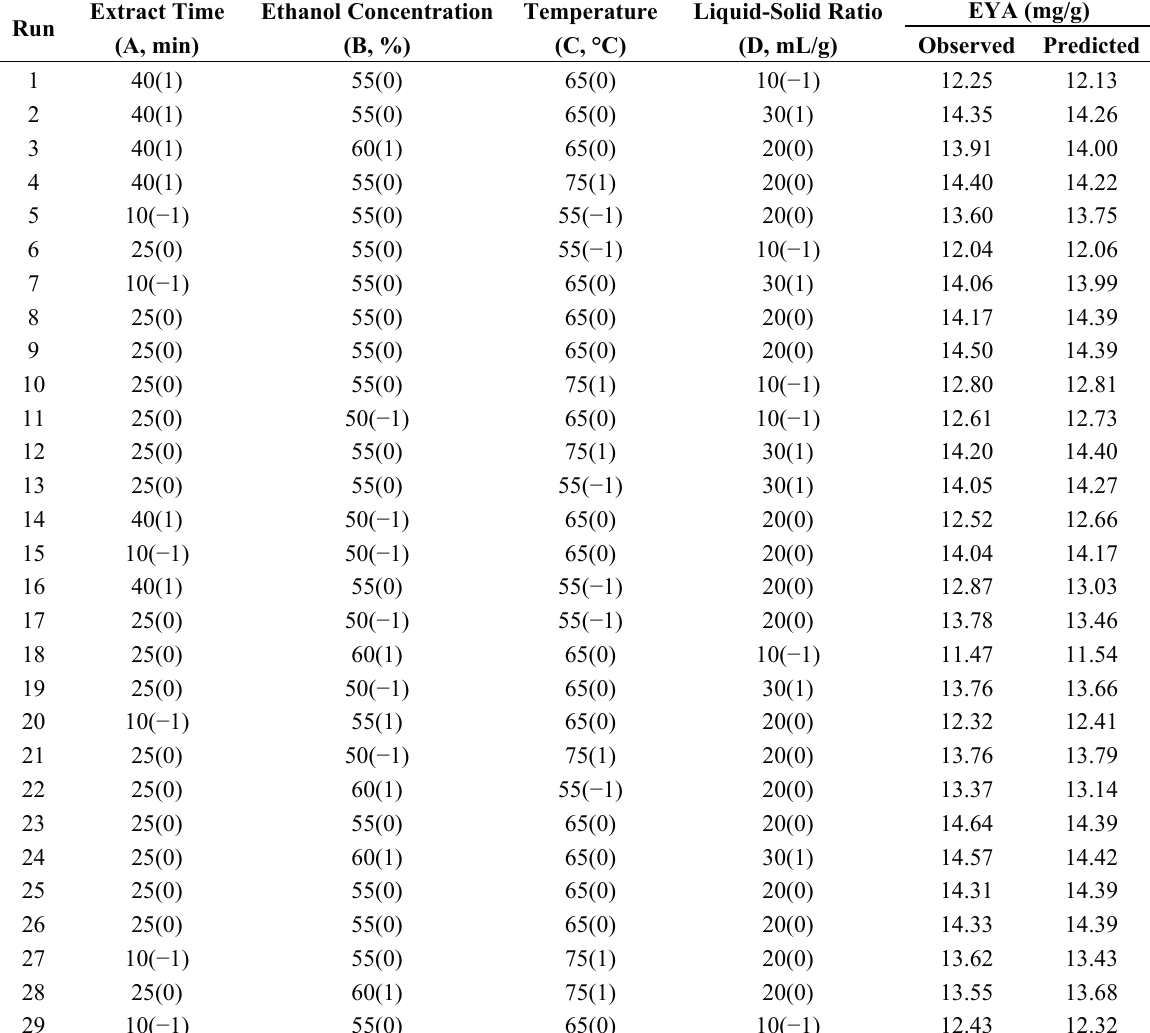
Table 1. Uncoded and coded Box-Behnken design with observed and predicted